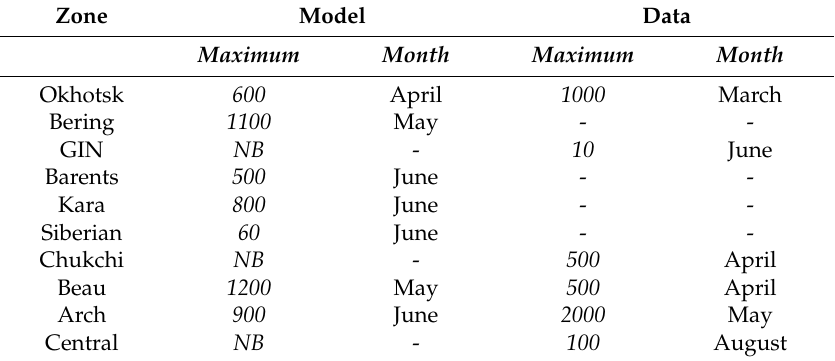
Table 2. Comparison of bottom layer chlorophyll maxima from a baseline model run, with the observations of Table 1 (mg/m 3 ), where data are available. A fixed layer thickness of 3 centimeters applies in the model. Geography, abbreviations and references are all defined as in the previous table; NB simply means there was no